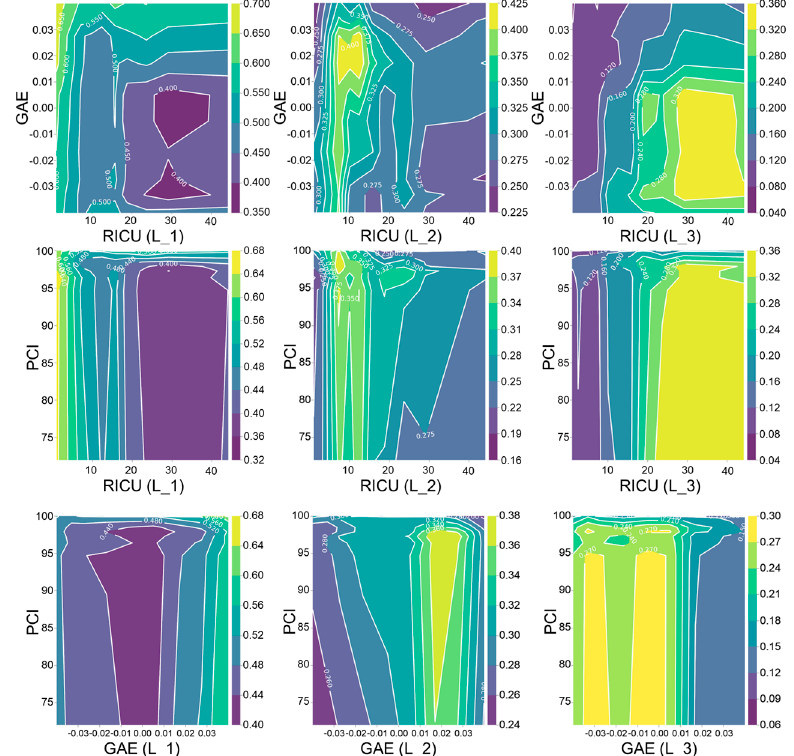
Figure 7. Feature variable partial dependence plot illustrating the effects of section risk by the interaction of RICU , GAE , and PCI ; the missing part of the value is filled by